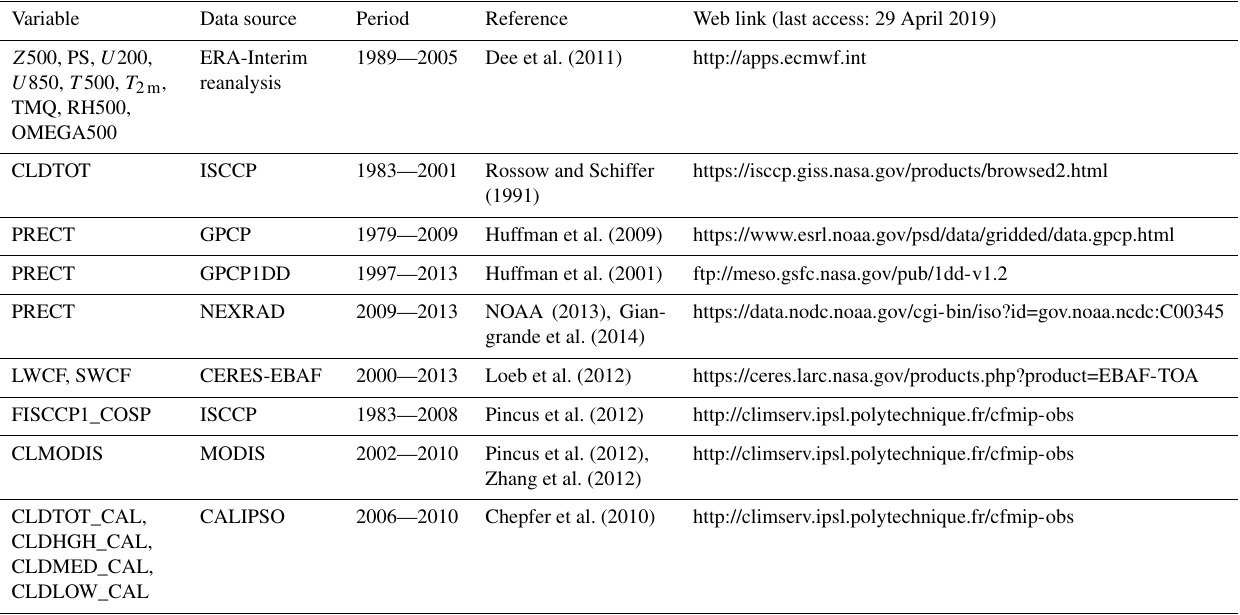
Table 2. Summary list of observational and reanalysis-based evaluation datasets for model performance.